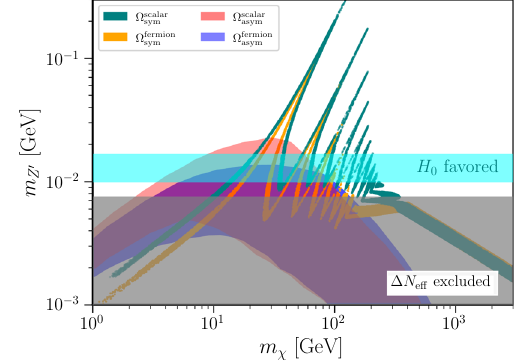
Fig. 5 Allowed parameter space of scalar (green) and fermionic Dirac (orange)DMmass m χ andgaugebosonmass m Z (cid:3) thatsatisfiesvelocity- dependent self-interaction rate σ/ m (cid:6) 1cm 2 / g ( < 0 . 1cm 2 / g) on dwarf-galaxy(cluster-galaxy)scaleswithDMvelocityfixedat v dwarf = 10km / s and v cluster = 1000km / s. Both of the data sets satisfy relic abundance requirement (cid:17) h 2 (cid:6) 0 . 12 [71]. Red (blue) band corresponds to the allowed parameter space for asymmetric scalar (fermionic) DM (with